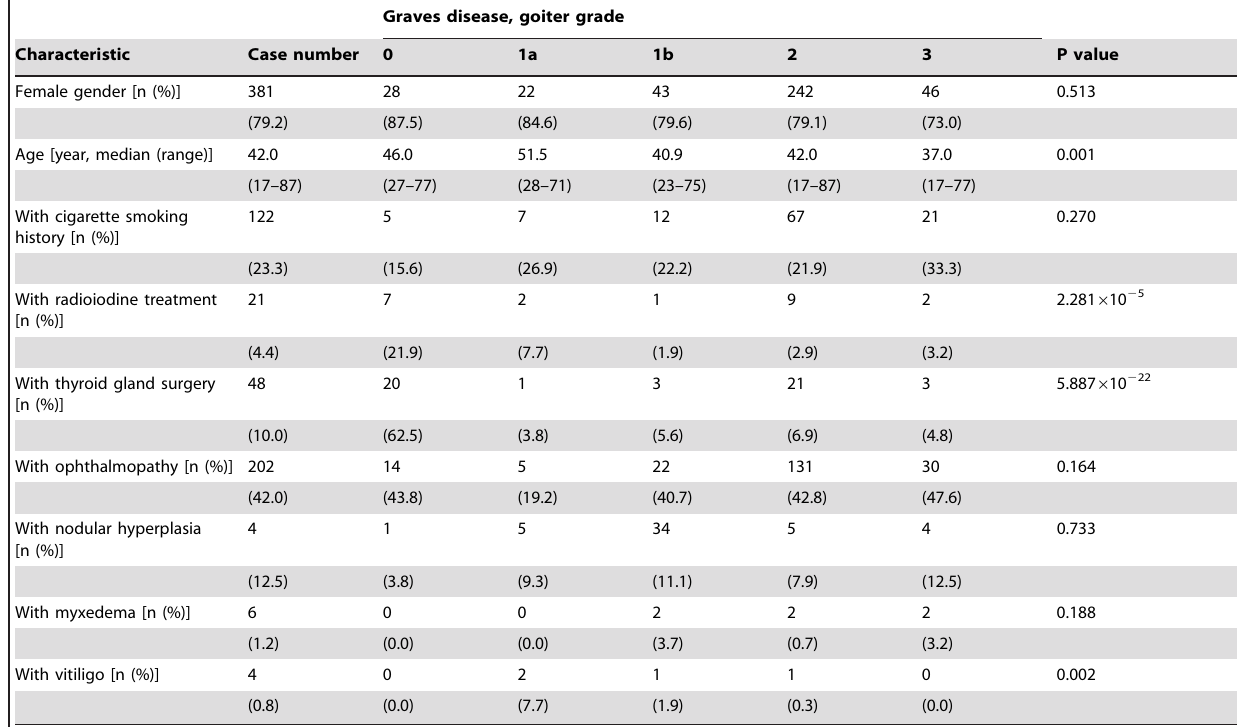
Graves disease, goiter